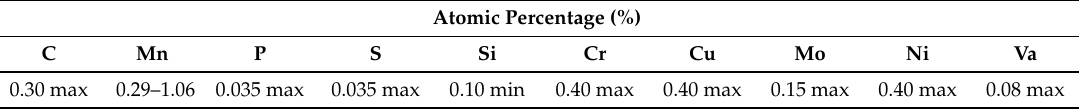
Table 1. Chemical compositions of the ASTM A106 grade B carbon steel pipe using a spectrometer.